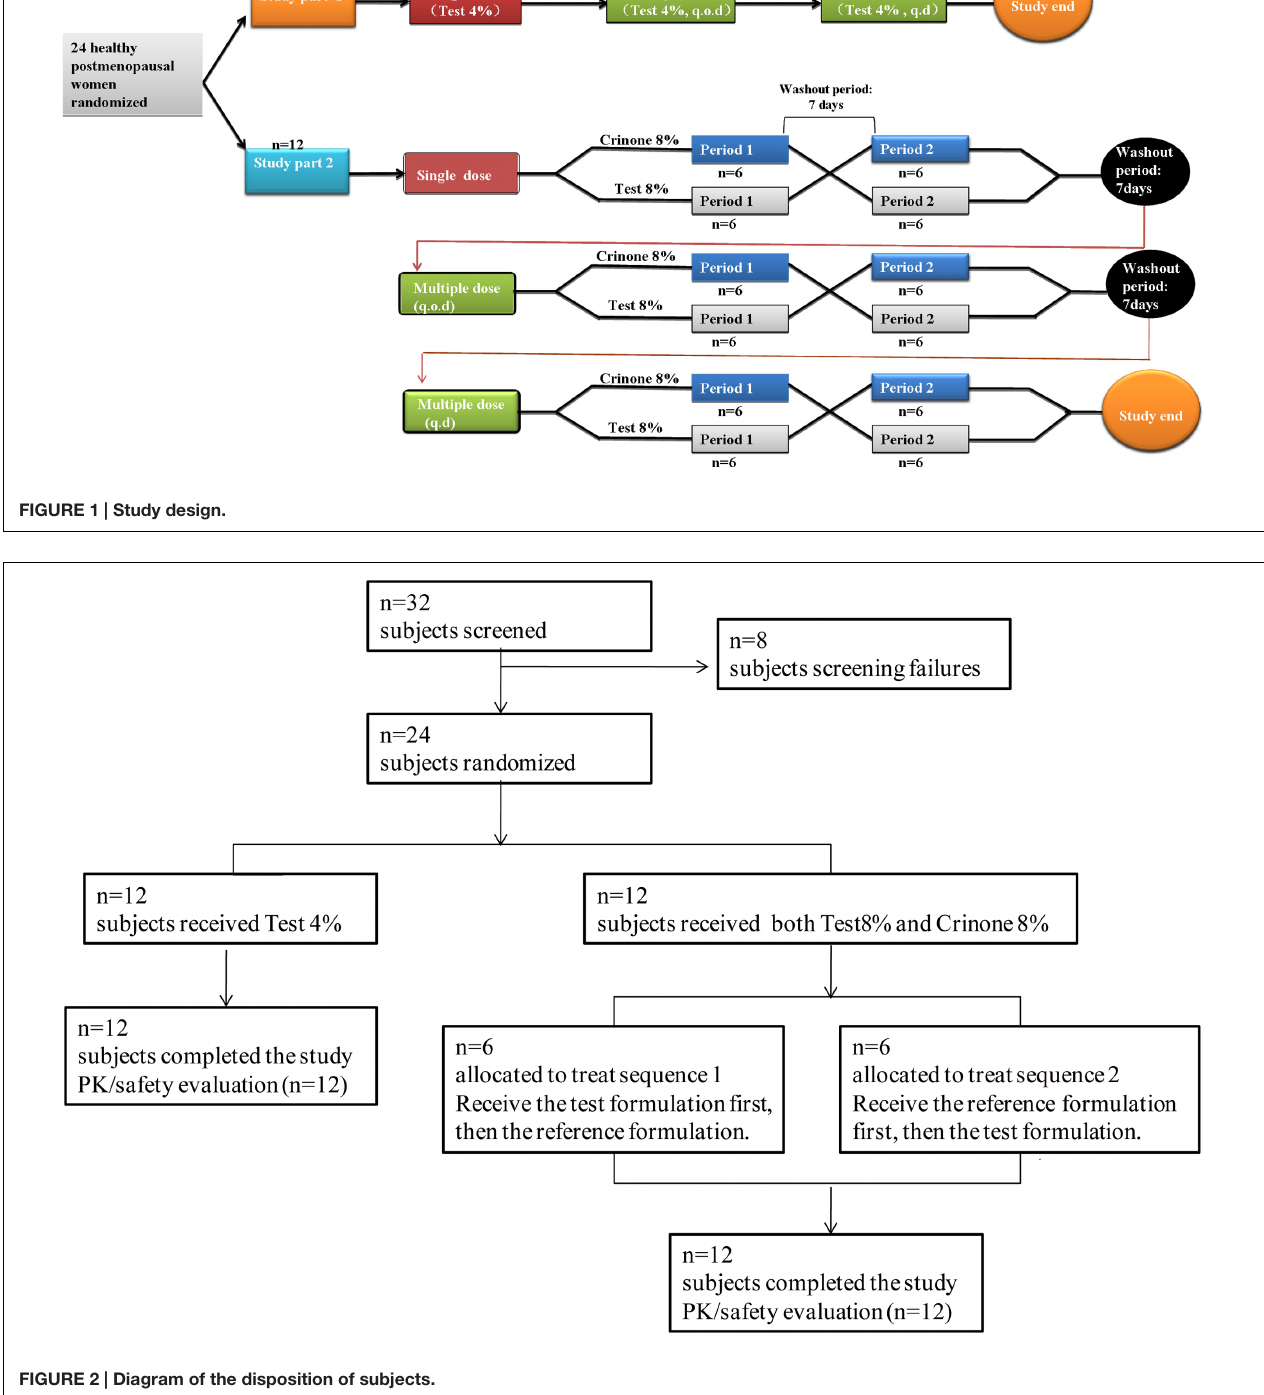
FIGURE 2 | Diagram of the disposition of subjects.